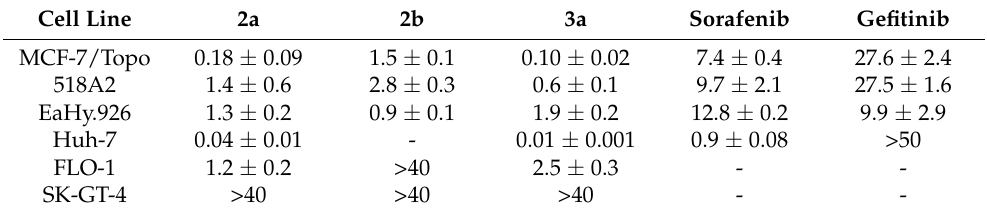
Table 2. Inhibitory activities (IC 50 values in µ M after 72 h of incubation) 1 of compounds 2a , 2b and 3a against MCF-7/Topo breast carcinoma, 518A2 melanoma, EaHy.926 endothelial/lung carcinoma, Huh-7 hepatocellular carcinoma, FLO-1 and SK-GT-4 esophageal adenocarcinoma cells. Sorafenib and gefitinib served as positive controls.